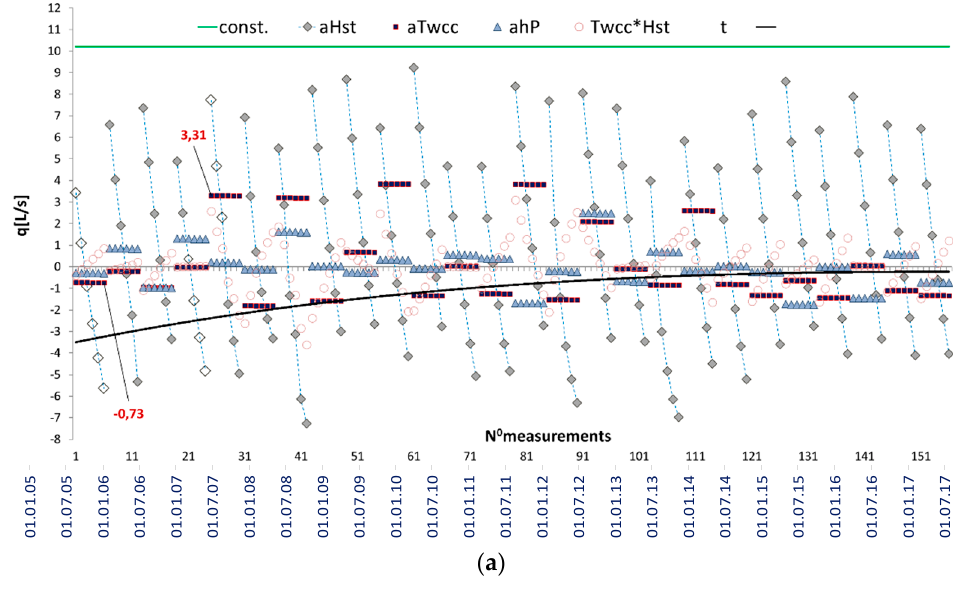
0501 01 . 01 . Figure 9. Cont